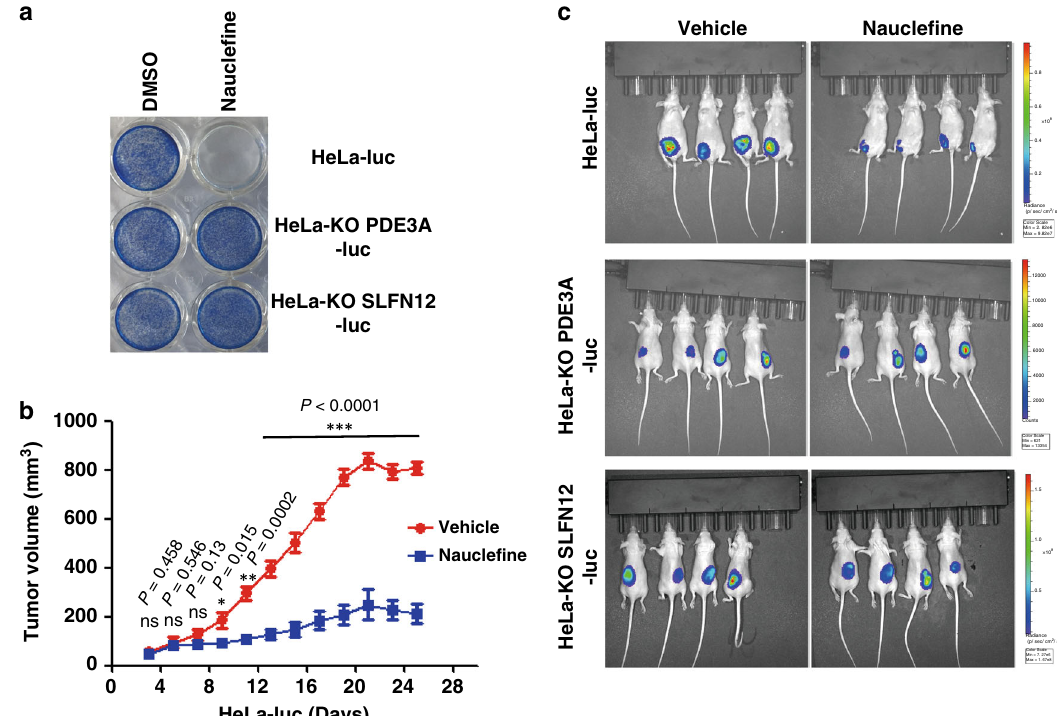
Fig. 6 Naucle fi ne inhibits growth of human tumor xenografts in mice. a Naucle fi ne (200 nM) was used to treat HeLa-luc, HeLa-KO PDE3A-luc, or HeLa- KO SLFN12-luc cells for 48 h, then cells were stained by methylene blue. b Mice implanted with WT HeLa cells were intratumorally injected with vehicle ( n = 4) or naucle fi ne ( n = 5) for 22 days. Tumor volumes were measured on the indicated days. Student ’ s t test (two-tailed, unpaired) was performed with mean ± SD. * p < 0.05; ** p < 0.01; *** p < 0.001; ns not signi fi cant. c Mice ( n = 4) implanted with WT or mutant HeLa cells were intratumorally injected with vehicle or naucle fi ne. The luciferase substrate was intraperitoneally injected to visualize tumor